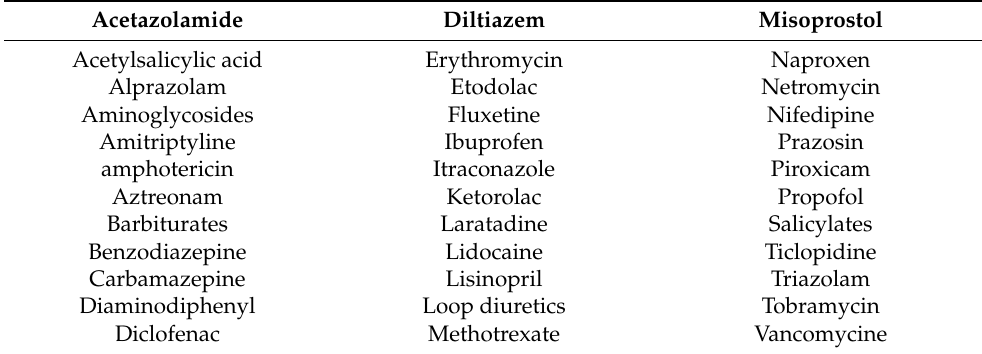
Table 15. Drugs with tinnitus